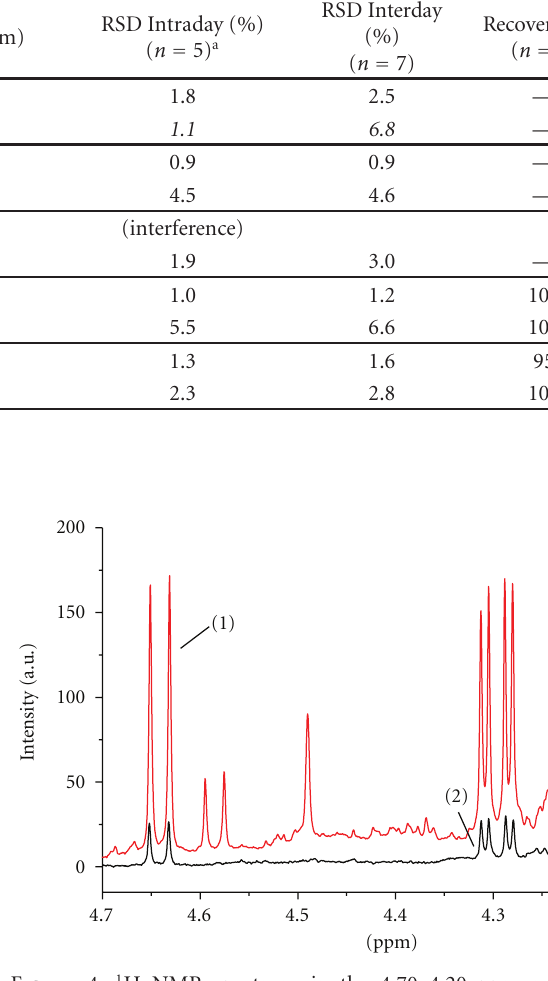
Figure 4: 1 H NMR spectrum in the 4.70–4.20 ppm range of medicinal alcohol (1) compared with hawthorn plant material